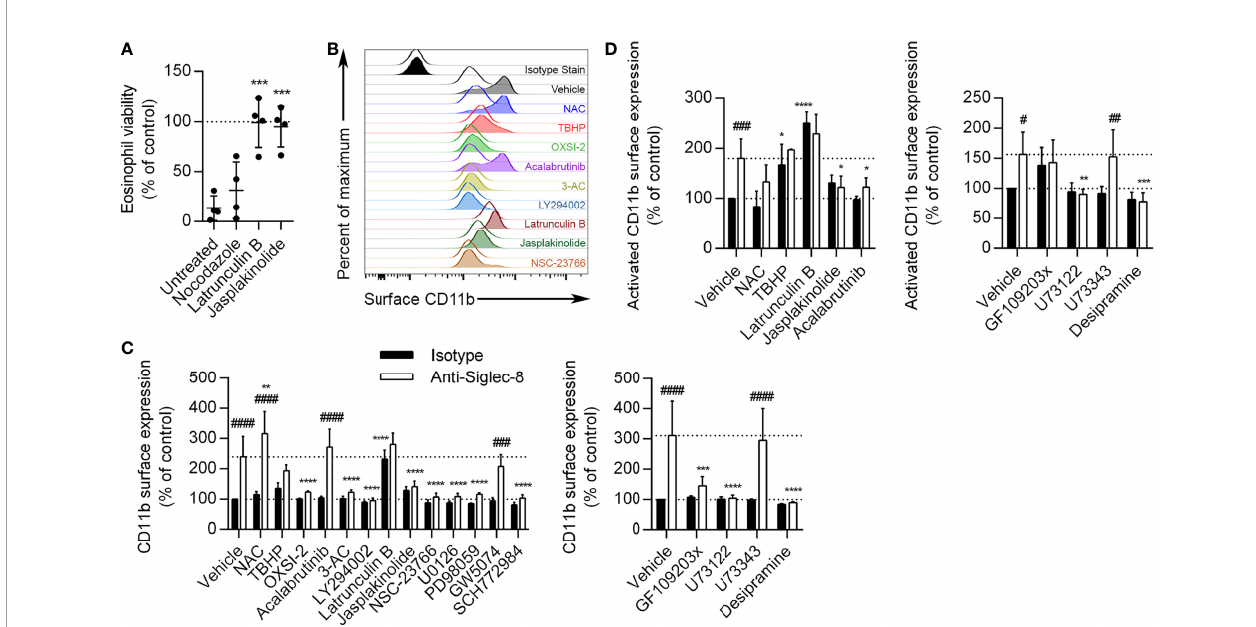
FIGURE 6 | Actin depolymerization is necessary and suf fi cient for CD11b surface upregulation and activation, and Btk is involved in CD11b activation but not upregulation. (A) Eosinophils were pretreated with the indicated disruptors of cytoskeletal dynamics for 30 min prior to treatment with anti-Siglec-8 or isotype control mAb. After 18 – 24 h, eosinophil cell viability was assessed by annexin V/DAPI staining as before, and normalized to the isotype control sample within each treatment. Individual results, means, and standard deviations are shown for 4 independent experiments. ***p < 0.0001 relative to vehicle control – pretreated eosinophils. (B) Following pretreatment with the indicated agents for 30 min and treatment with anti-Siglec-8 ( fi lled histograms) or isotype control mAb (empty histograms) for 120 min, surface expression of CD11b was assessed by fl ow cytometry on live (DAPI-negative) eosinophils. Isotype control mAb-stained samples are included for reference. Histograms are representative of 3 independent experiments. (C) CD11b expression levels on eosinophils treated with anti-Siglec-8 (white columns) or isotype control mAb (black columns) were quanti fi ed and normalized to those of control eosinophils. Data represent means ± standard deviations of 3 independent experiments. **p < 0.01, ***p < 0.001, ****p < 0.0001 relative to within – antibody stimulation group vehicle control sample. ### p < 0.001, #### p < 0.0001 relative to within – pretreatment group isotype control sample. (D) Following pretreatment with the indicated agents for 30 min and treatment with anti-Siglec-8 (white columns) or isotype control mAb (black columns) for 120 min, conformational activation of CD11b on live (DAPI-negative) eosinophils was measured by fl ow cytometry. Activated CD11b levels were normalized to those found on control eosinophils. Data represent means ± standard deviations of 4 independent experiments. *p < 0.05, **p < 0.01, ***p < 0.001, ****p < 0.0001 relative to within – antibody stimulation group vehicle control sample. # p < 0.05, ## p < 0.01, ### p < 0.001 relative to within – pretreatment group isotype control